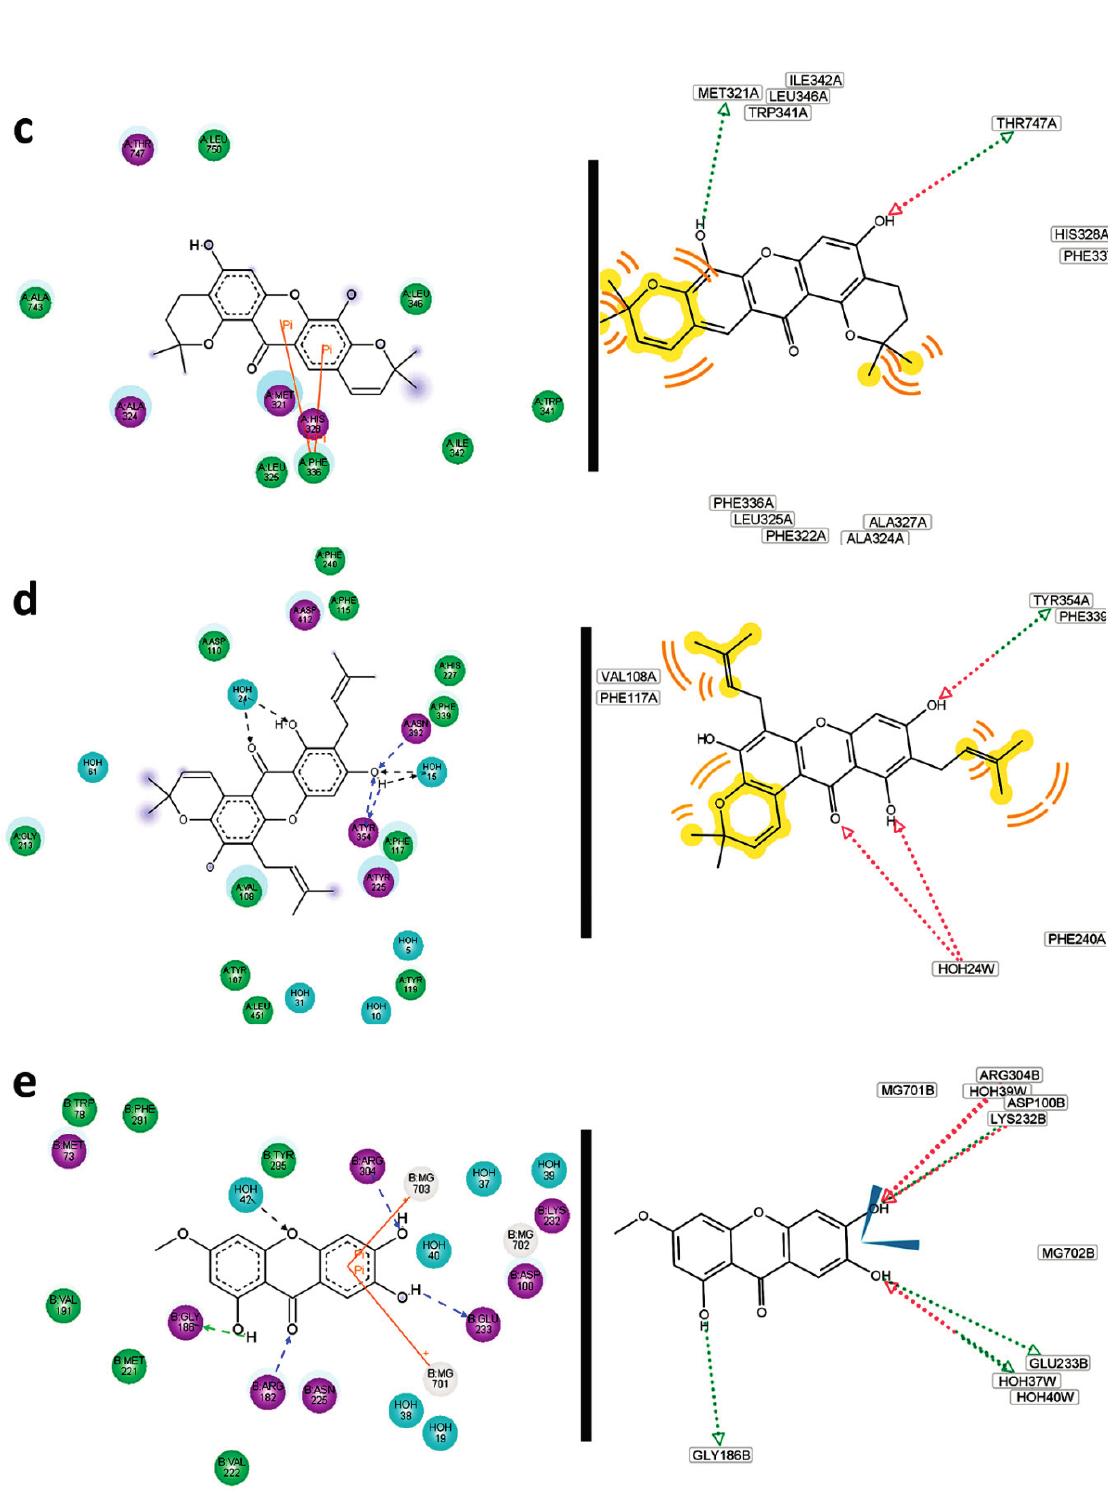
Figure 16. Residual interaction maps for selected structures constructed by Discovery Studio (left) and Ligand Scout (right). ( a ) 215 —R2; ( b ) 254 —R4; ( c ) 220 —R7; ( d ) 256 —R8; ( e ) 116